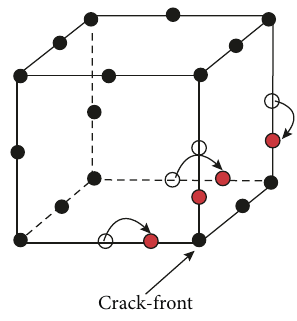
Figure 14: Transferring middle knots of elements in tip of crack to 1/4 distance [26].